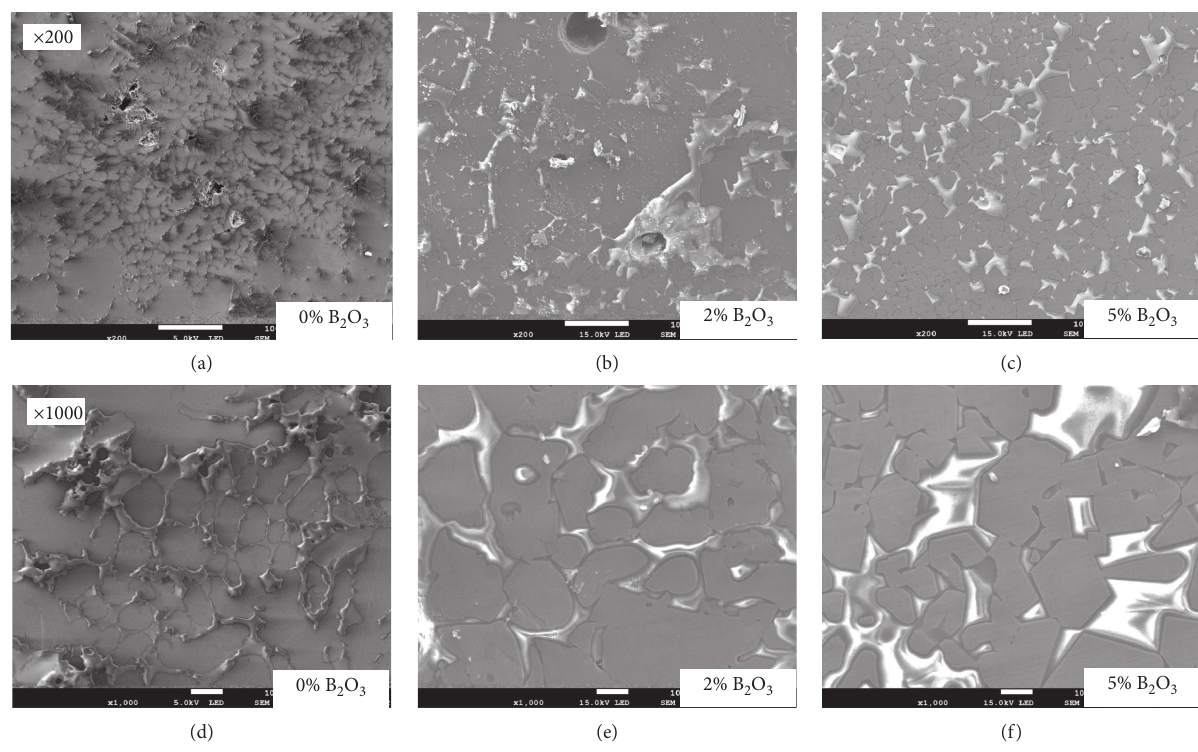
Figure 9: SEM of H-VTM with different B